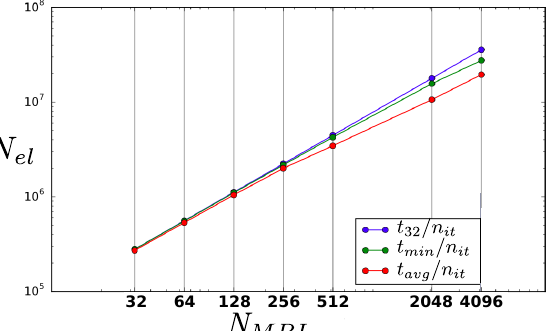
Figure 5. Weak scalability curves obtained for SEM3D on Tera 1000-1 (Europe’s first petaflop computer, hosted at CEA, France), expressed as time rate of mesh elements N el processed per chunk of 32 MPI core each. In blue, the linear scalability curve represents the ideal optimum result (perfect linear scalability). Green and red lines portray the best and average performances obtained instead. The blue curve represents the theoretical linear scalability, i.e., considering the sin- gle chunk of 32 MPI processes (Tera 1000-1 is featured by bullx DLC 720 nodes, Xeon E5-2698v3 16C 2.3GHz, with Infiniband FDR). Green and red lines portray the best and average performances obtained over all the employed nodes. In each case, quasi-linear scalability curves are obtained, although the cluster working load may have an impact on the communication